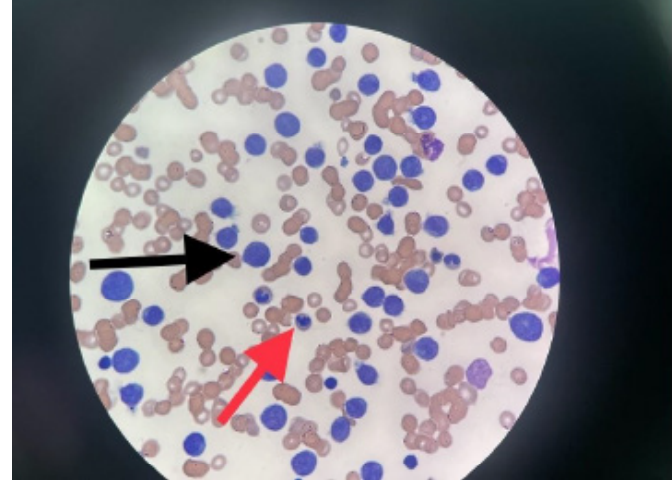
Image 2. Peripheral blood smear with marked leukocytosis and numerous circulating blasts with monocytic features consistent with acute myeloid leukemia